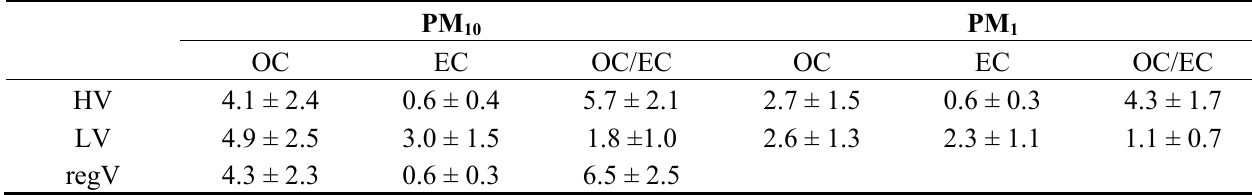
Table 1. Mean concentrations of organic carbon (OC) and elemental carbon (EC) of the